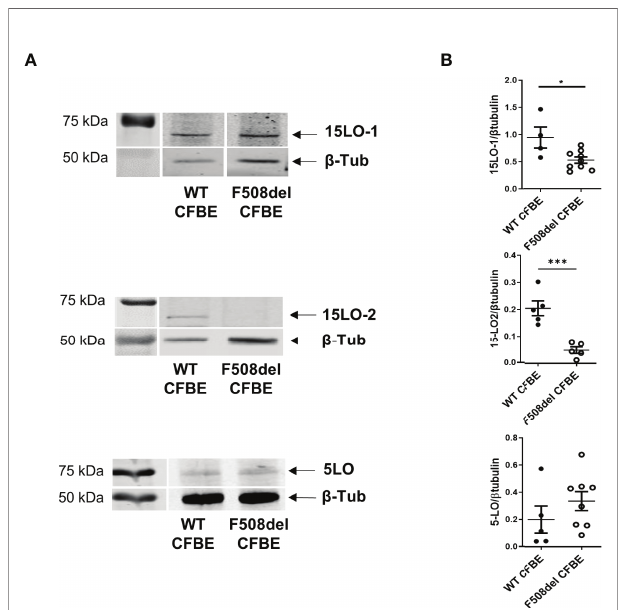
FIGURE 7 | Expression level of 15-LO1, 15-LO2 and 5-LO in CFBE41o- cell line expressing WT CFTR and F508del CFTR. (A) Typical western- blotting results. (B) Comparison of the mean enzymes expression levels between both cell lines. *p < 0.05 and ***p <